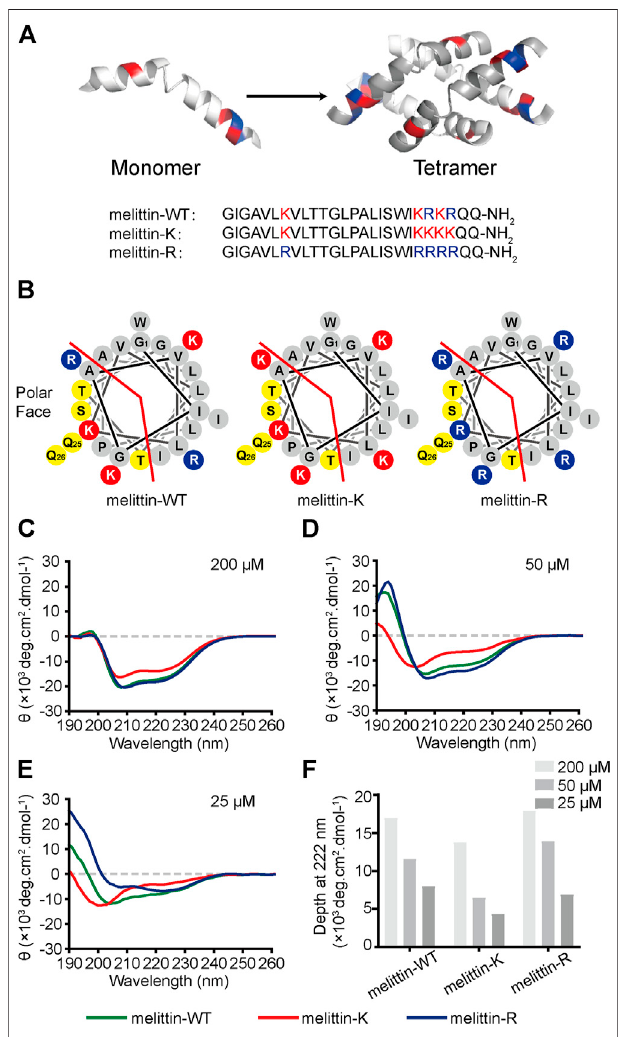
FIGURE 1 | Impacts of K vs. R on the folding structure of melittin. (A) Lateral view of a globally amphiphilic melittin-WT peptide and the peptide sequences of melittin-WT, -K, and -R. (B) The helical wheel diagrams of melittin peptides, showing the nonpolar and polar faces of the helix, separatedbytheredline.ThesolidreddiscswithaKlettersigndepicttheside chains of lysine amino acid residues, while the solid blue discs with an R letter represent the ones of arginine residues. The yellow discs show the polar- uncharged residues and gray discs represent the nonpolar ones. (C – E) The CD spectra of melittin peptides at 200 μ M (C) , 50 μ M (D) , and 25 μ M (E) . (F) The depth of molar ellipticity of melittin peptides at 222 nm.